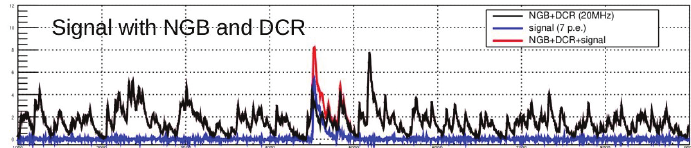
Figure 14: Signal with NGB and DCR